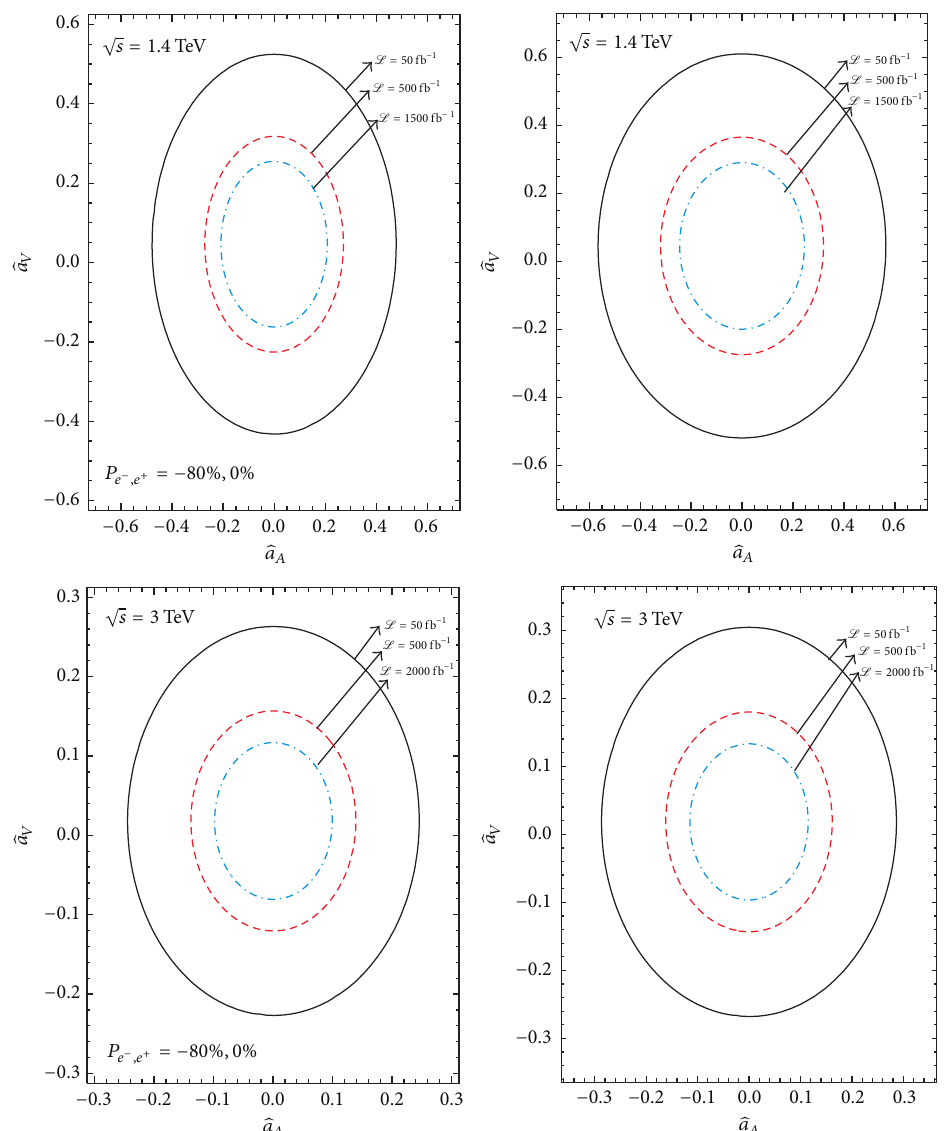
Figure 6: Limits contours at the 95 % C . L . in the ̂𝑎 𝑉 − ̂𝑎 𝐴 plane for 𝑒 + 𝑒 − → 𝑒 + 𝛾 ∗ 𝑒 − → 𝑡𝑏 ] 𝑒 𝑒 + ( 𝛾 ∗ is the Weizsacker-Williams photon) with √ 𝑠 = 1.4, 3 TeV, 𝑄 2 = 2 GeV 2 and polarized and unpolarized